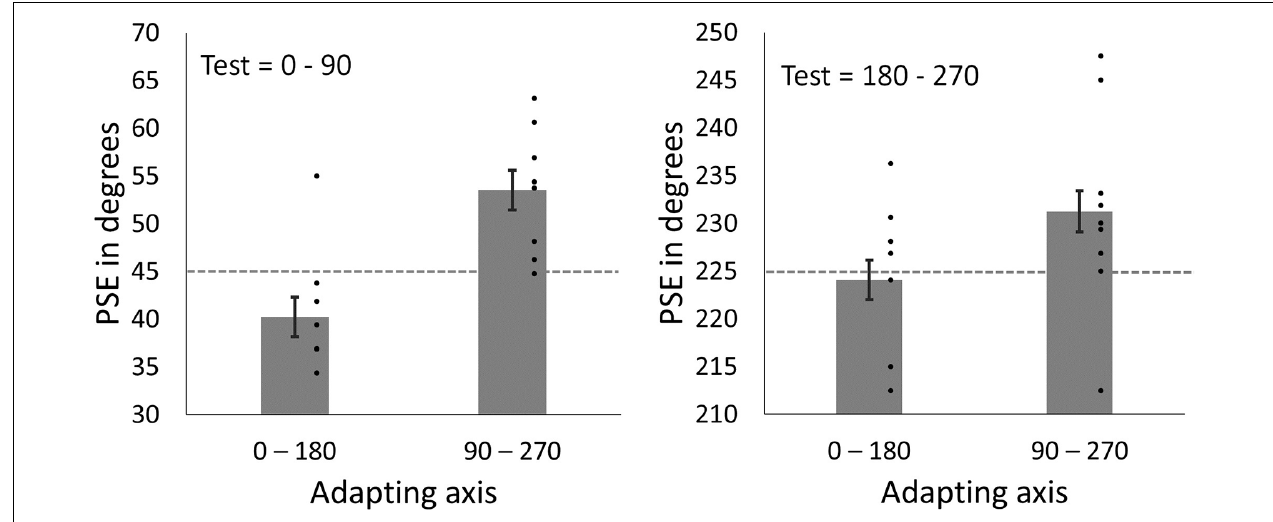
FIGURE 8 | PSEs for test faces from the 0 ◦ –90 ◦ quadrant (left) and for test face from 180 ◦ to 270 ◦ quadrant (right) after adapting to horizontal (0 ◦ –180 ◦ ) and vertical (90 ◦ –270 ◦ ) axes. Dashed lines represent points of objective equality (i.e., the point at which the face images are horizontally distorted in equal magnitudes). Dots show amplitudes for individual participants. Error bars show